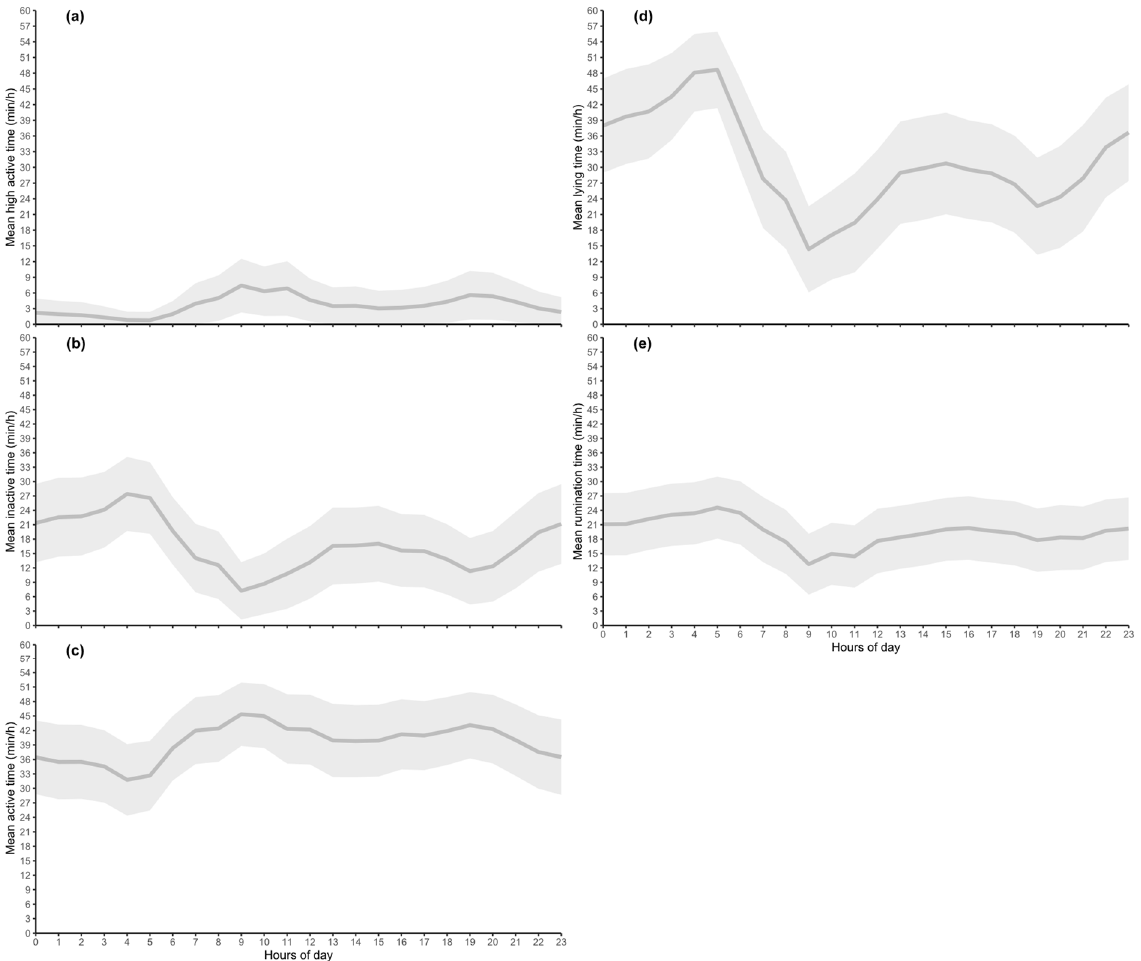
Figure 3. Mean ‘normal’ behavior (dark grey line) and SD (light gray area) in 428 clinically healthy calves within one day. The parameters high active ( a ), inactive ( b ), active ( c ), lying ( d ), and rumination ( e ) are presented.